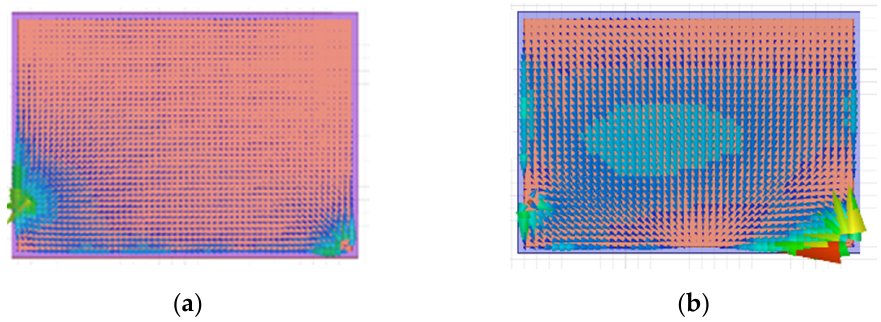
Figure 9. Impact of the shorting pin on the surface current distribution at ( a ) 402.5 MHz and at ( b ) 2.45 GHz.